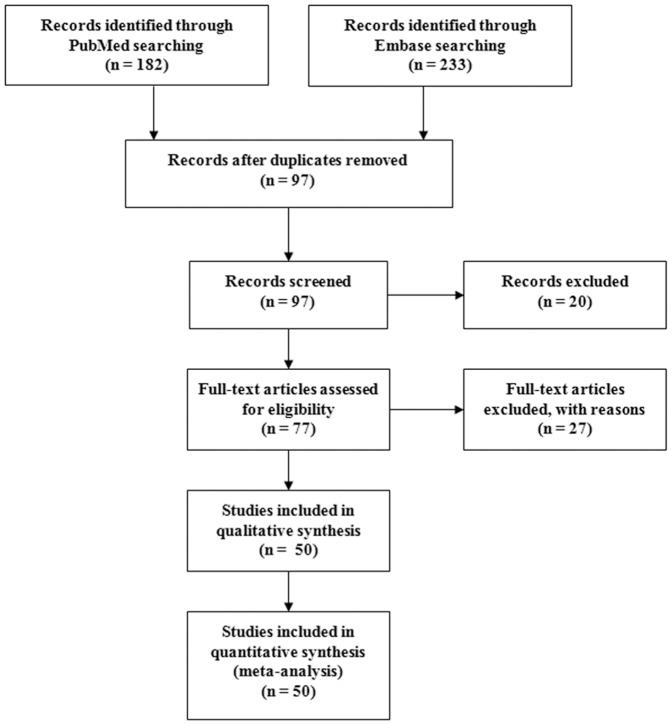
Flow diagram of the literature search.